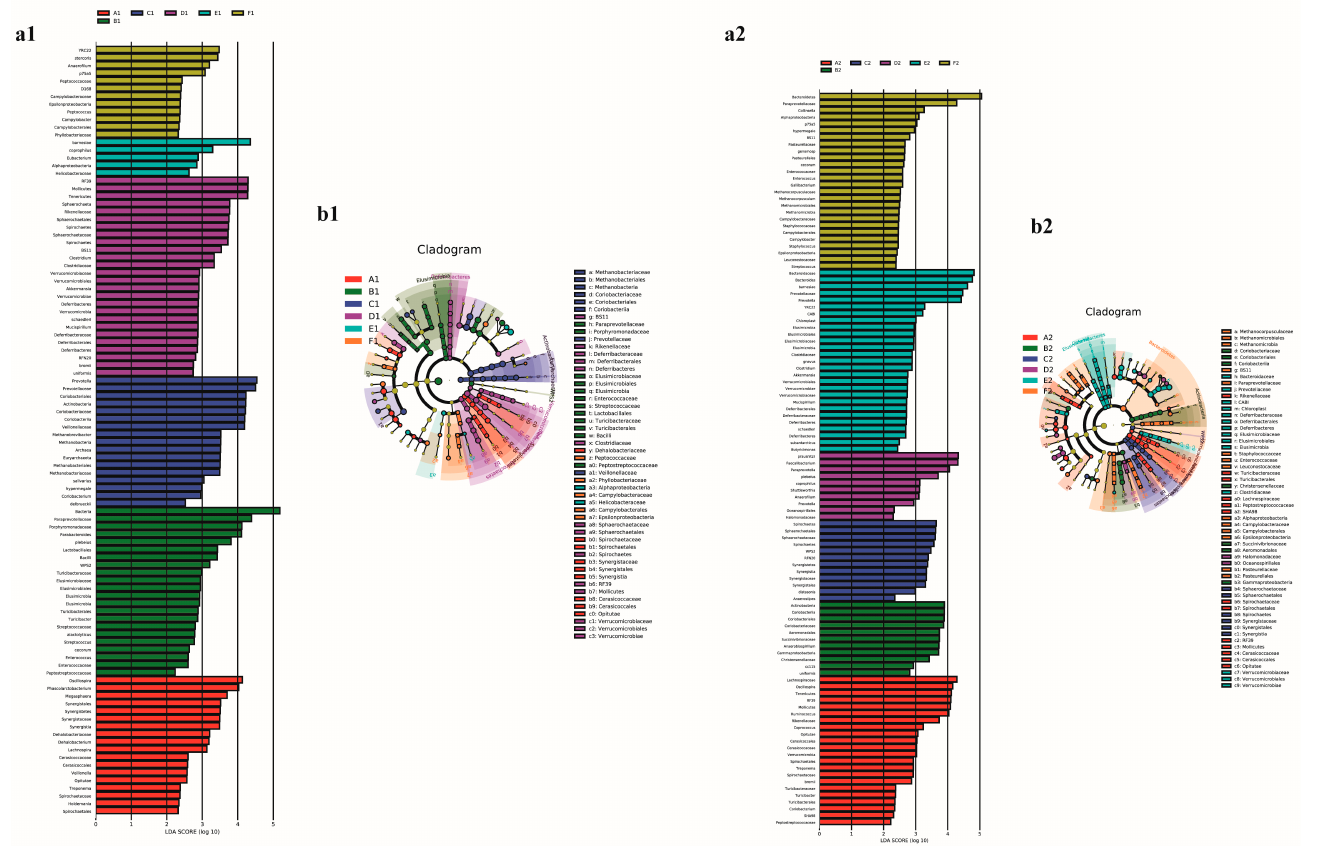
Figure 7. LEfSe identified the most differentially abundant taxa of each group. ( a1 ) The LDA score at day 28, ( b1 ) the cladogram at day 28, ( a2 ) the LDA score at day 56, and ( b2 ) the cladogram at day 56. The taxonomic cladogram obtained from LEfSe analysis of 16S sequences (relative abundance ≥ 0.1%). The length of the histogram represented the effect size of different bacteria and the higher score of LDA of the bacteria represents the more dominant bacteria in the sample. The circle from inside to outside represented the taxonomic rank from kingdom to species in the cladogram; the size of the circle was positively correlated to the abundance. Only taxa that meet an LDA score > 2 and p < 0.05 are